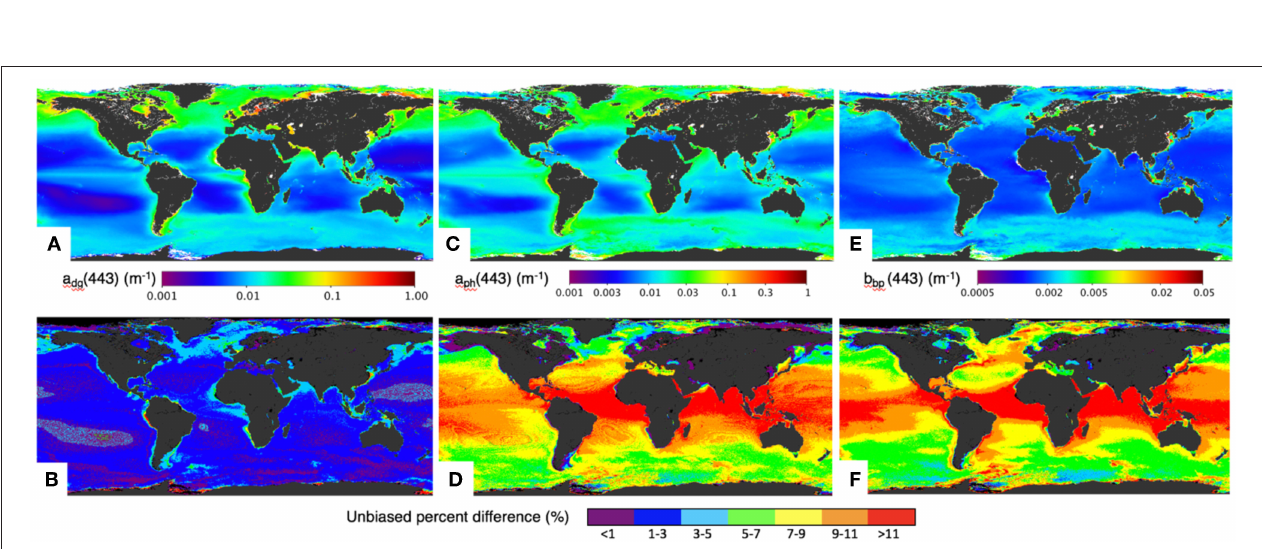
FIGURE 8 | Global IOPs calculated using SeaWiFS mission-long R rs ( λ ) and the UPD between IOP values calculated using SeaWiFS and VIIRS wavelength suites (SeaWIFS = satellite 1 and VIIRS = satellite 2 in Equation 7). Geophysical values and UPD for a dg (443) shown in (A,B) , for a ph (443) in (C,D) , and for b bp (443) in (E,F) .